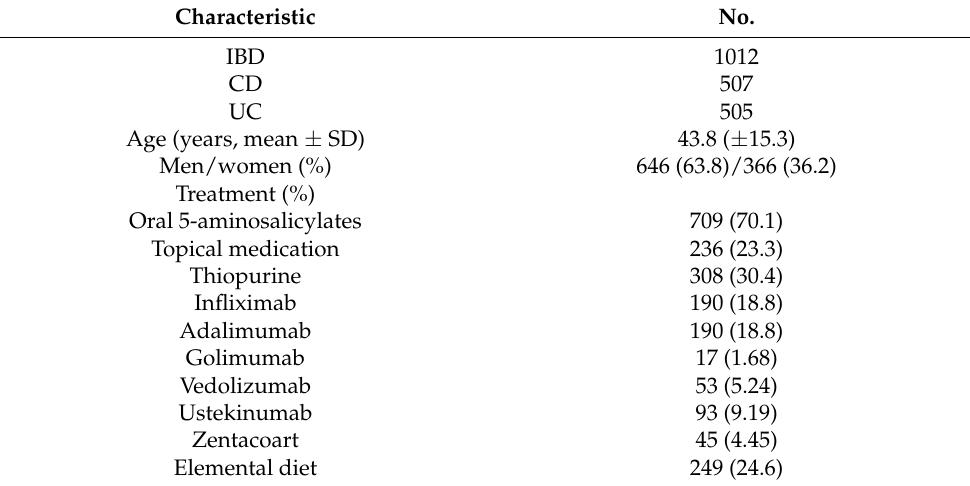
Table 2. Characteristics of IBD patients at Tohoku University hospital who were identified in the